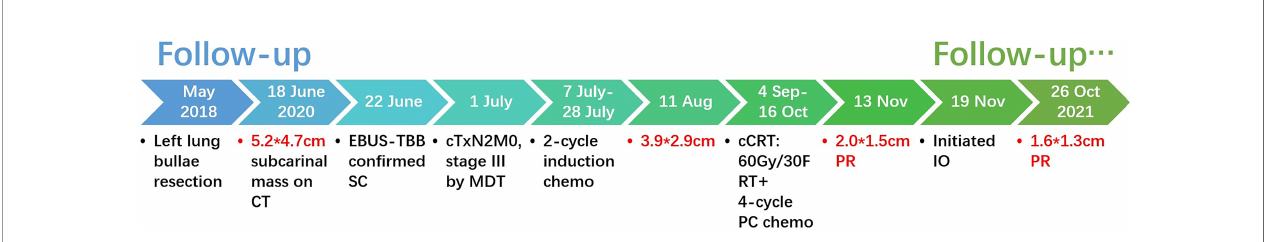
FIGURE 3 | Timeline of the clinical events and treatment strategies. cm, centimeter; PR, partial response; Gy, gray; F, fraction; RT, radiotherapy; PC, nab-paclitaxel + carboplatin; IO,